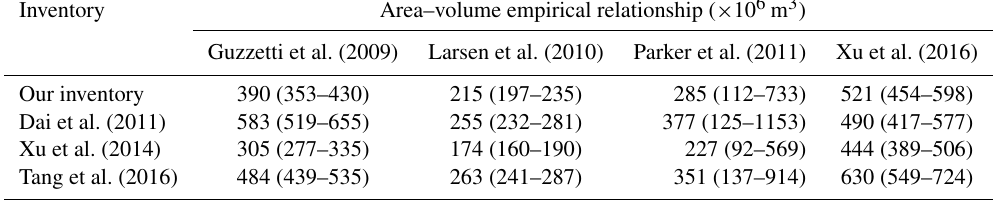
Table 5. Comparison between the total volumes of coseismic landslides in the portion of the Wenchuan earthquake-affected area that was covered by all the inventories (i.e. our inventory and those of Dai et al., 2011; Xu et al., 2014; Tang et al. 2016), estimated through area– volume empirical relationships (Guzzetti et al., 2009; Larsen et al., 2010; Parker et al., 2011; Xu et al., 2016). The first value in each cell is the central value, while those in brackets result from the uncertainty ( ± 1 σ ) of the calibrated parameters of the relationships.